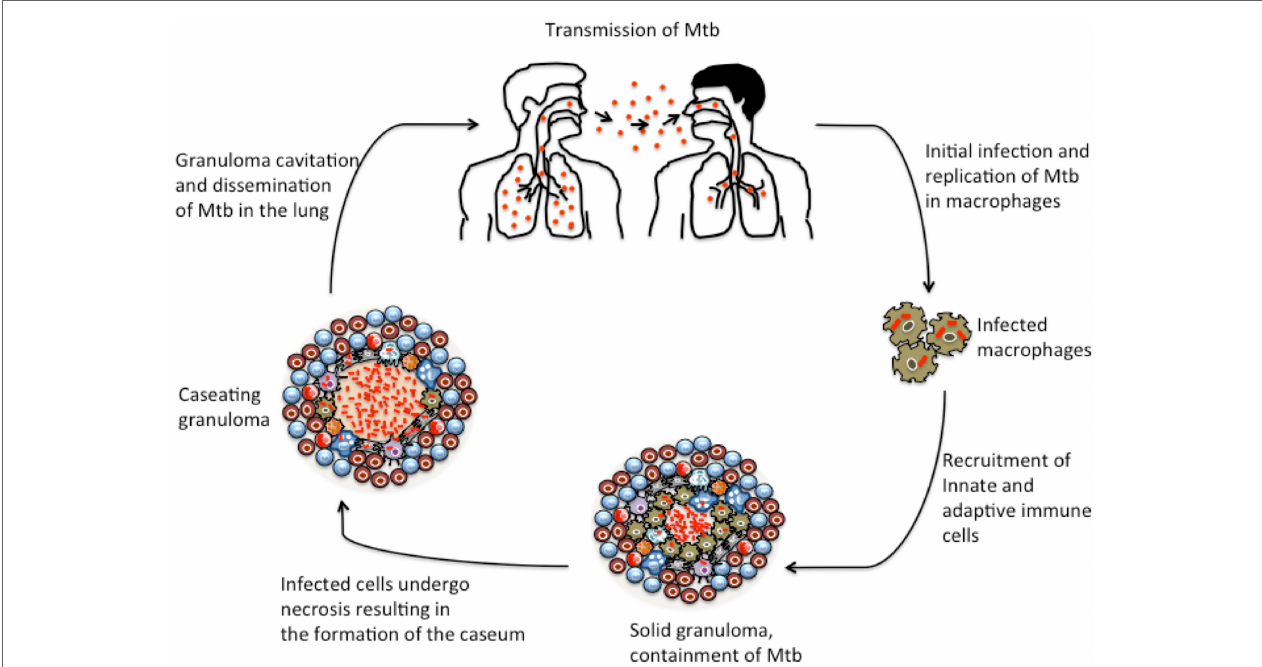
FiGURe 2 | Granuloma development during TB progression . The initial stages of TB infection involve inhalation of M. tuberculosis bacilli into the lung and phagocytosis by resident alveolar macrophages. Mtb elicits local inflammatory response resulting in the recruitment of monocytes and macrophages and other innate immune cells to the site of infection. The macrophages further differentiate into other specialized cells, such as epithelioid macrophages, foamy macrophages, and multi-nucleated giant cells. Upon induction of adaptive immunity, the granuloma gets a peripheral lymphocytic cuff mainly characterized by B and T cells. This is the balanced solid state in which many granulomas persist and restrict the bacilli at their center. However, as the disease progresses, increased necrotic breakdown of granuloma cells leads to the accumulation of caseum, which may result in cavitation of granulomas. Ultimately, as the granuloma cavitates and collapses into the lung, Mtb bacilli are released into the